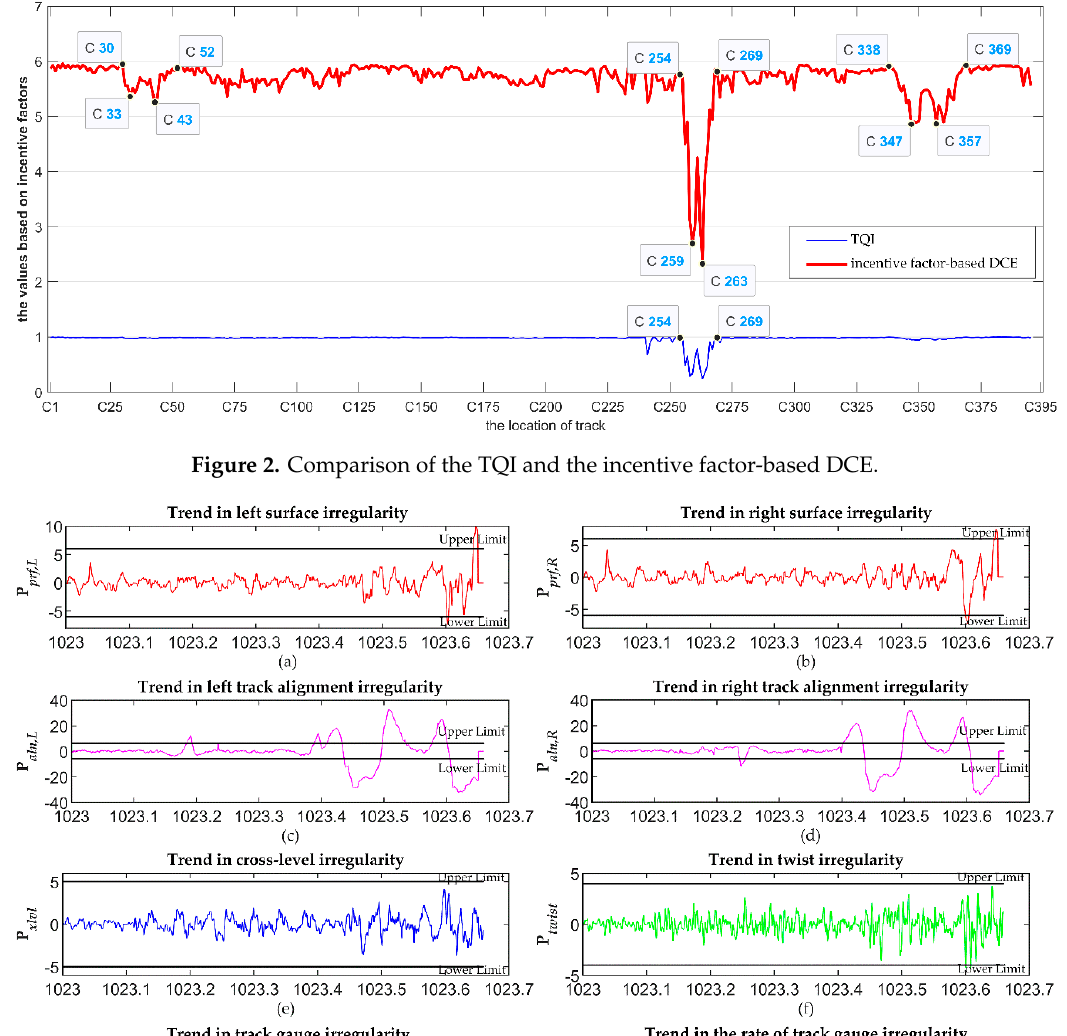
Table 14. Peak management standard- Ⅰ levels for the geometric parameter for the speed of 200~250 km/h.